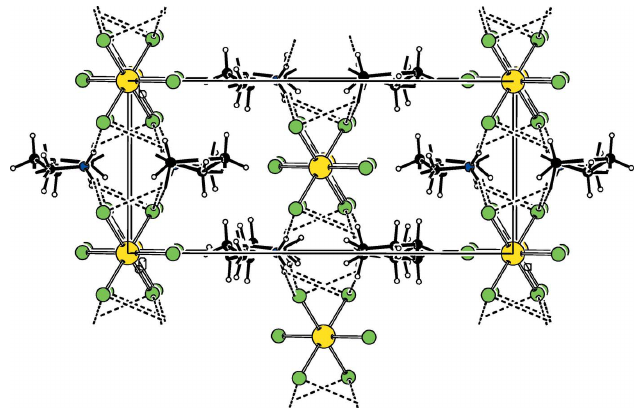
Figure 3 A view along the c axis of the crystal packing of the title compound. The N—H (cid:2)(cid:2)(cid:2) Cl hydrogen bonds (Table 1) are shown as dashed lines. Only one component of the disordered cation is shown.